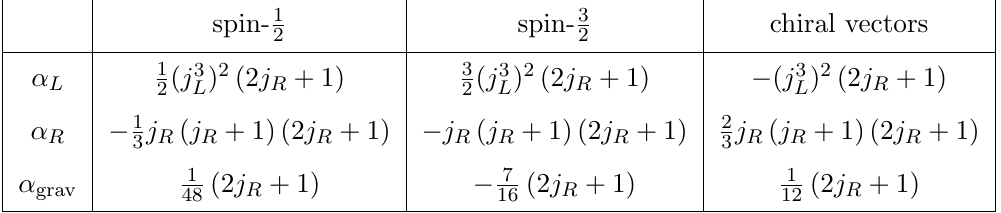
Table 1 . Contributions of a single field to the left-, right- and gravitational Chern-Simons terms. (entry of The table should be read as α I = sgn( M ) 4 π ×